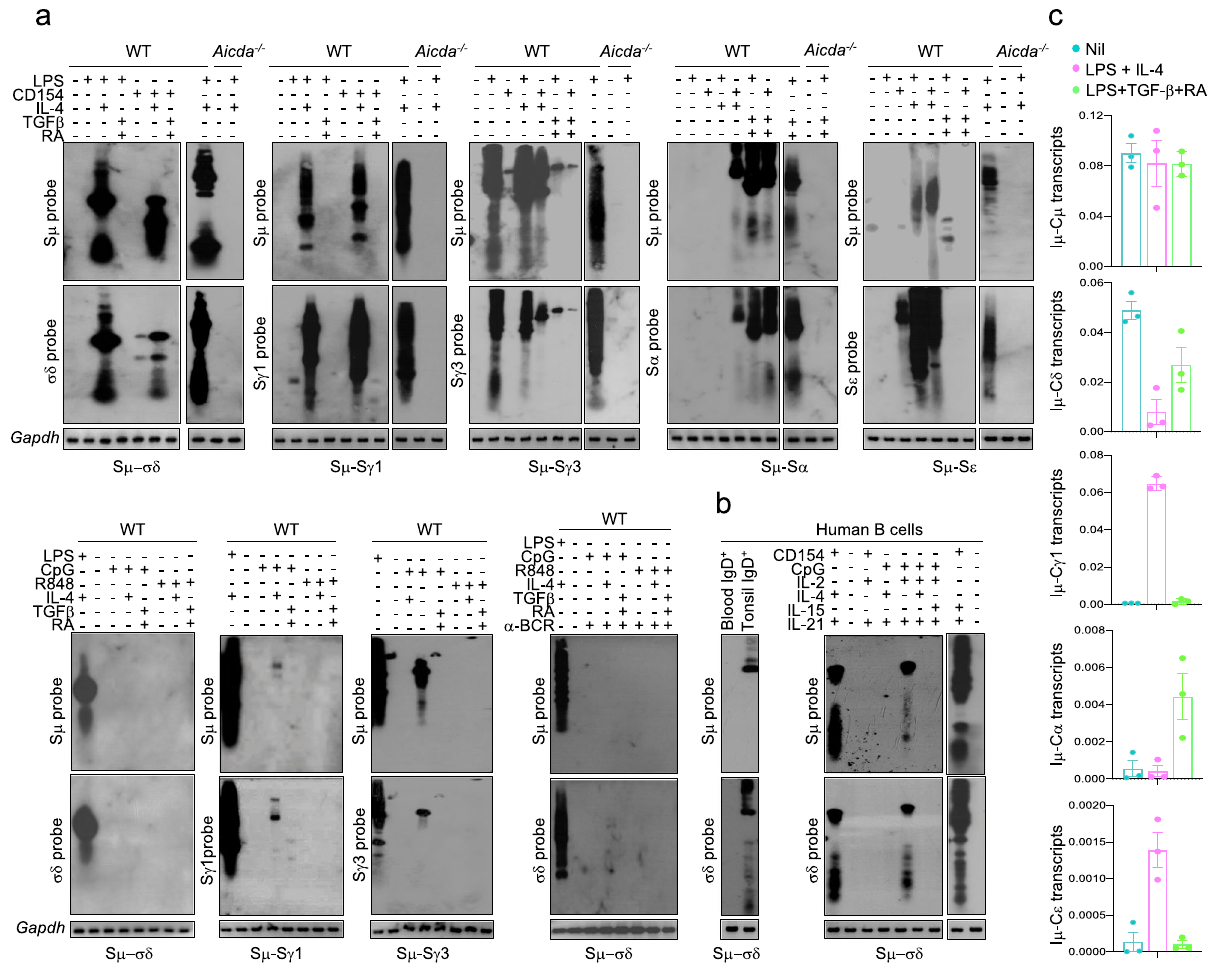
Fig. 2 Identi fi cation of stimuli inducing CSR to IgD and S μ – σδ junctions in mouse and human B cells. a Unstimulated mouse (wildtype) C57BL/6 B cells and naïve Aicda − / − B cells (nil), or C57BL/6 and naïve Aicda − / − B cells stimulated for 96 h with LPS, LPS plus IL-4, LPS plus TGF- β and RA, CD154, CD154 plus IL-4, CD154 plus TGF- β and RA, CpG alone, CpG plus IL-4, CpG plus TGF- β and RA, R848 alone, R848 plus IL-4, R848 plus TGF- β and RA, or CpG plus IL-4, or R848 plus IL-4 in the presence of anti-BCR Ab were analyzed for recombined S μ – σδ , as well as recombined S μ – S γ 1, S μ – S γ 3, S μ – S α , and S μ – S α DNA by nested PCR using forward I μ and reverse C δ primers, or forward I μ and reverse S γ 1, S γ 3, S α or S ε primers, respectively, followed by Southern-blotting using a speci fi c S μ , σδ , S γ 1, S γ 3, S α , or S ε probe, as indicated. b Recombined S μ – σδ DNA in human tonsil IgD + B cells, blood naive IgM + IgD + B cells, or blood naive IgM + IgD + B cells stimulated with CD145 or CpG plus IL-2 and IL-21, IL-4 and IL-21, or IL-2, IL-4 and IL-21, or IL-15 and Il-21, were analyzed 120 h post-stimulation by nested PCR using forward I μ and reverse C δ primers, followed by Southern-blotting using speci fi c human S μ or σδ probe. Data are one representative of three independent experiments yielding comparable results. c Quanti fi cation of germline/post-recombination I μ -C δ transcripts, post-recombination I μ -C γ 1 , I μ -C α , and I μ -C ε transcripts in wildtype C57BL/6 B cells stimulated with nil, LPS plus IL-4, or LPS plus TGF- β and RA, analyzed 72 h post-stimulation by qRT-PCR and normalized to β -Actin expression. Each dot represents data obtained with B cells from an individual mouse ( n = 3 per group). Data are mean ± SEM. Source data are provided as a Source Data fi sequencing of junctional S μ – σδ or S μ – S X DNAs. Of all stimuli and TLR9 ligand CpG (for human B cells) in conjunction with different cytokines and/or BCR-cross-linking to induced CSR to used, only LPS or CD154 plus IL-4 induced CSR to IgD in mouse IgD. Unlike IgG, IgA, and IgE, IgD can be expressed in the B cells (Fig. 2a), and only CpG plus IL-2 and IL-21, or CD154 plus absence of CSR on surface of mature naive IgM + IgD + B cells, at IL-4 or IL-15 and IL-21 induced CSR to IgD in human B cells high levels in a Zfp318-dependent fashion 10,11 . Accordingly, Aicda (Fig. 2b). CSR to IgD was also detected in vivo in tonsil B cells. The knockout B cells, in which CSR to IgD is abolished, can display effectiveness of the stimuli that did not induce CSR to IgD was robust surface IgD, at a level comparable to wild-type B cells 5 . veri fi ed by the respective induction of expected S μ – S γ 1, S μ – S γ 3, Therefore, expression of IgD, as detected by surface/intracellular S μ – S α or S μ – S ε DNA recombination (IgG1, IgG3, IgA or IgE) staining and/or fl ow cytometry, does not necessarily re fl ect S μ – σδ (Fig. 2a) — no CSR to IgD, IgG, IgA or IgE occurred in Aicda − / − B recombination events, thereby making detection of recombined cells. In all cases, CSR was further con fi rmed by detection of post- S μ – σδ DNA the direct and positive proof of CSR to IgD. recombination I μ -C γ 1, I μ -C γ 3, I μ -C α and I μ -C ε transcripts at 72 h of culture — as post-recombination I μ -C δ transcripts are indis- tinguishable from germline I μ -C δ s-m RNA transcripts and identi fi cation of ampli fi ed DNA by blotting and hybridization consistent with high levels of the latter in naïve B cells, I μ -C δ with speci fi c internal DNA probes (Fig. 1 inset), complemented by ampli fi cation products were less abundant in class-switched IgD